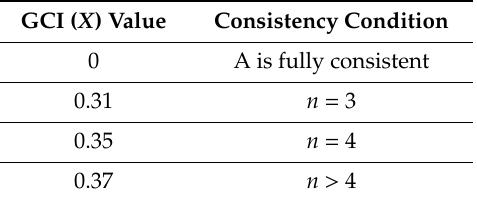
Table 5. Geometric consistency index (GCI) threshold value [75].